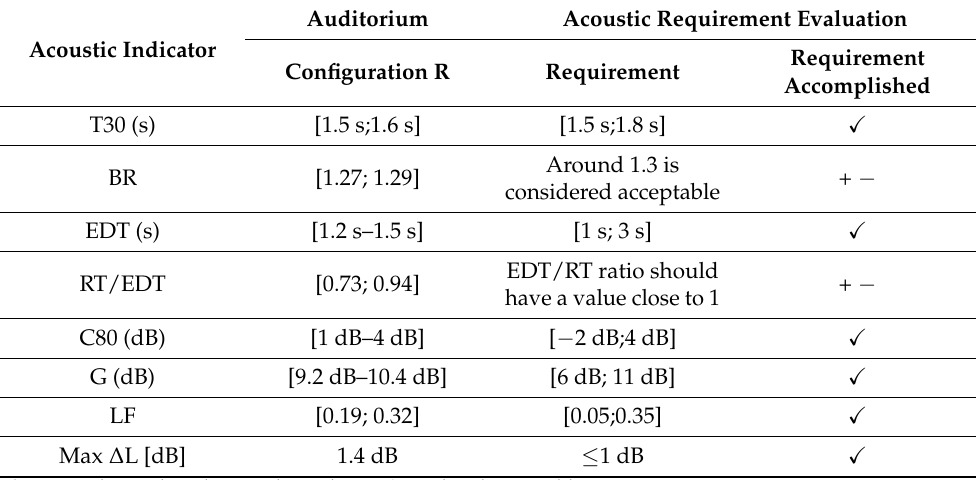
Table 11. Single number acoustic indicators for the auditorium for configuration